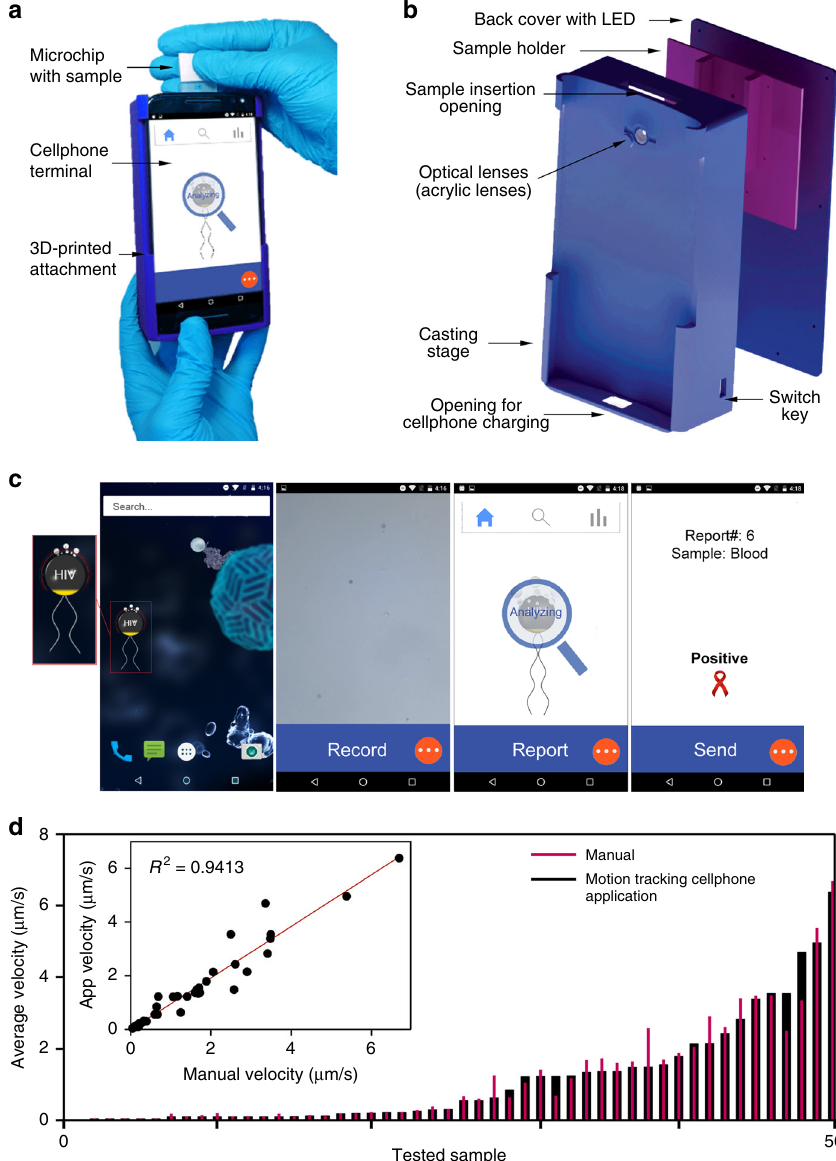
Fig. 4 Design of the CALM system. a Operating CALM system with a cellphone optical accessory and a disposable microchip. b Exploded 3D schematic of the cellphone attachment. The main components of the cellphone attachment including a casting stage with optics, sample holder, and back cover with LED was printed using PLA. c Motion tracking application used to detect and measure the motion of DNA-motors in H 2 O 2 solution. d Correlation between the performance of the motion tracking application and bright- fi eld light microscopy coupled with the ImageJ software in velocity detection of different motor samples ( n = 50). R 2 is the coef fi cient of determination of the linear regression analysis